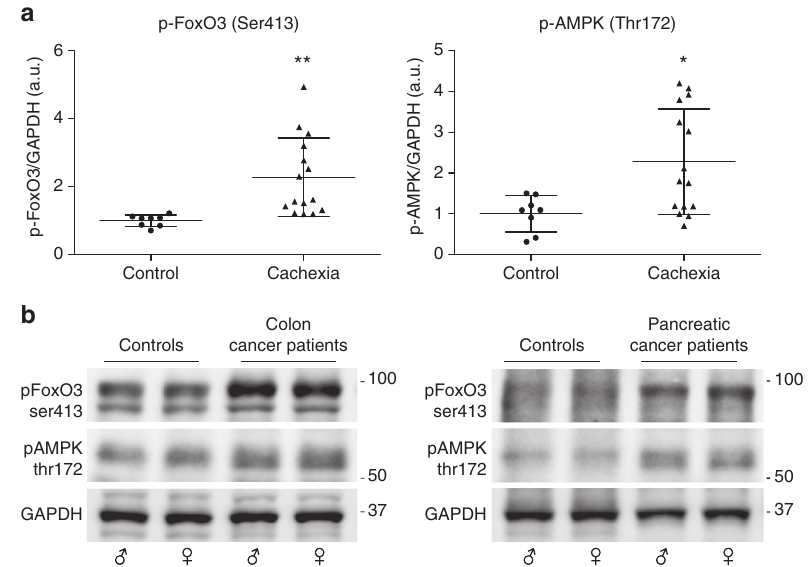
Fig. 9 Cachectic cancer patients show increased levels of p-FoxO3Ser413 and p-AMPKThr172 in rectus abdominis muscle. a p-FoxO3 (Ser413) and p-AMPK (Thr172) levels were measured by immunoblot in rectus abdominis muscles from non-neoplastic patients ( n = 8) and cachectic cancer patients ( n = 15). GAPDH serves as loading control. Data are presented in scatter dot plot, lines at means ± SD. Statistical analysis was performed by using Student ’ s unpaired t -test. * p < 0.05; ** p < 0.01. b Representative western blots from non-neoplastic patients (controls), colon cancer, and pancreatic cancer patients are